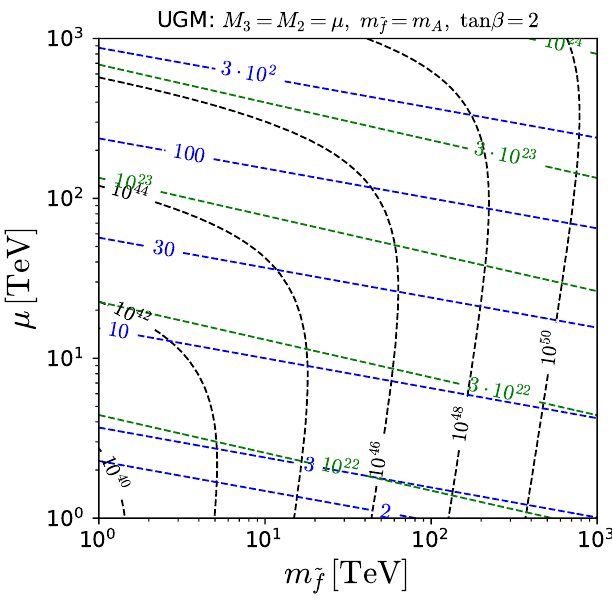
Figure 2 . The low energy SUSY parameter space ( m ~ f versus (cid:22) plane) for the UGM scenario with M 3 = M 2 = (cid:22); m A = m ~ and tan (cid:12) = 2. The dashed black, green and blue contours represent the f values of (cid:28) ( p K + (cid:22) (cid:23) )/yrs, M H /GeV and T S /TeV, respectively, calculated in the missing partner C ! SU(5) model in ref.